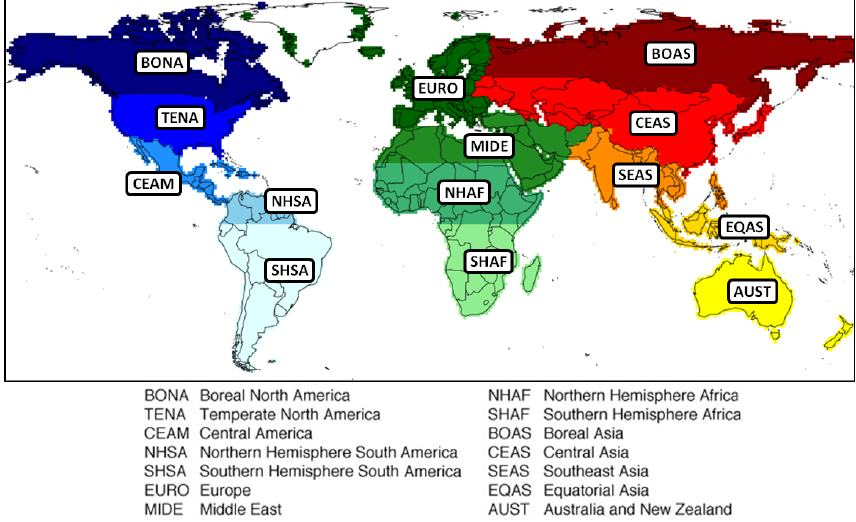
Figure 1. Global Fire Emissions Database (GFED) world regions of emission as used in the SOFT-IO v1.0